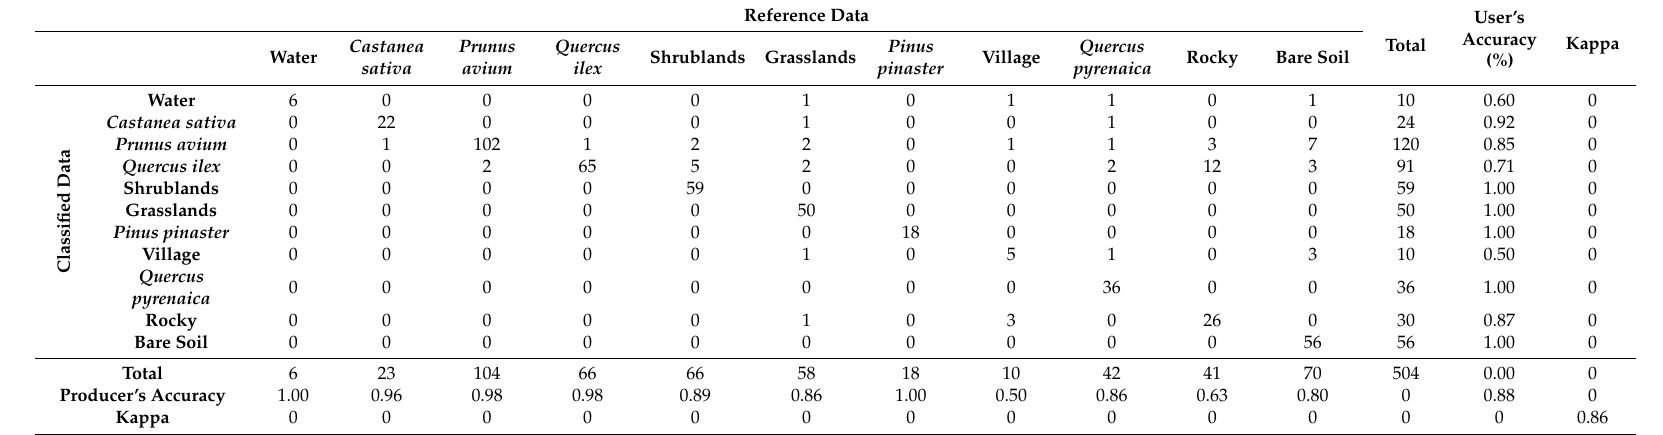
Table 7. Error matrix of vegetation